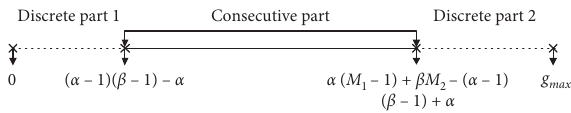
Figure 4: Schematic diagram of virtual array element distribution.